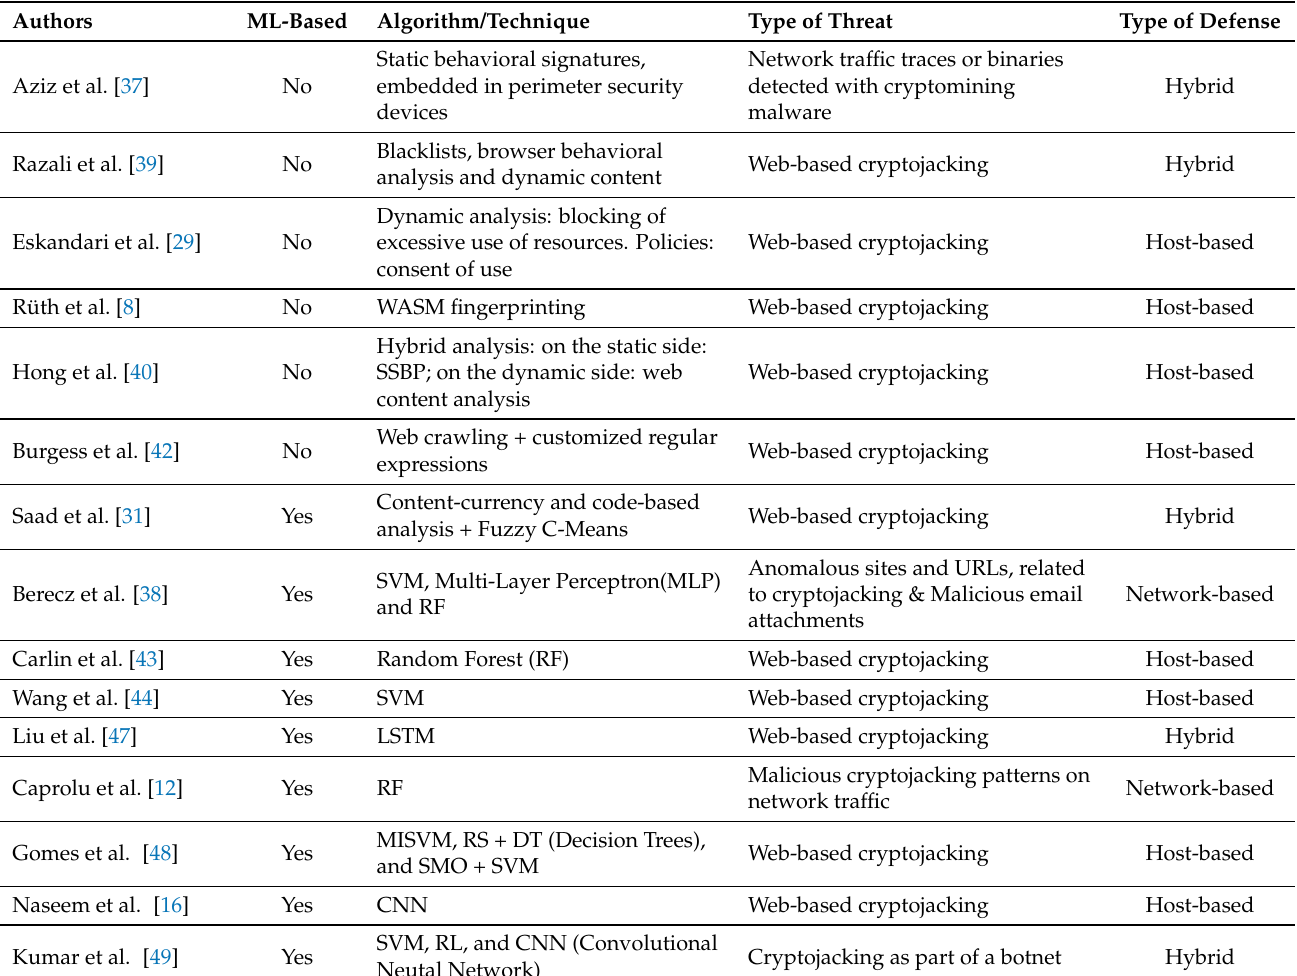
Table 1. Related work on detection of cryptojacking and cryptomining threats in the web